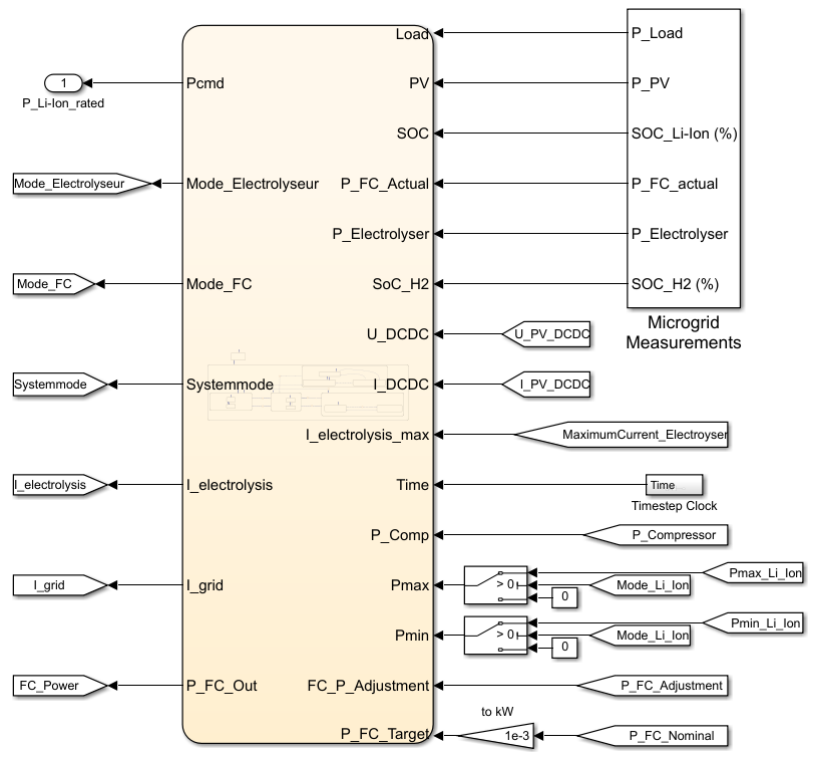
Figure 4. Input and output parameters for the control algorithm realised in Simulink chart.